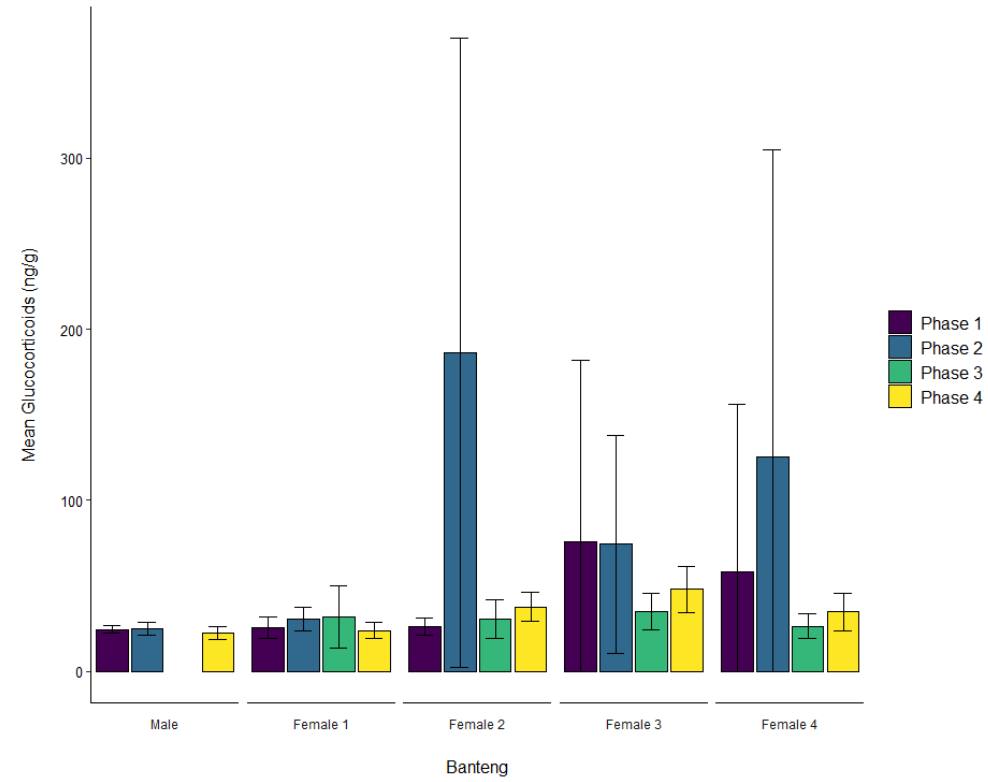
Figure 6. Means and standard deviations for fecal glucocorticoids by phase for individual banteng.